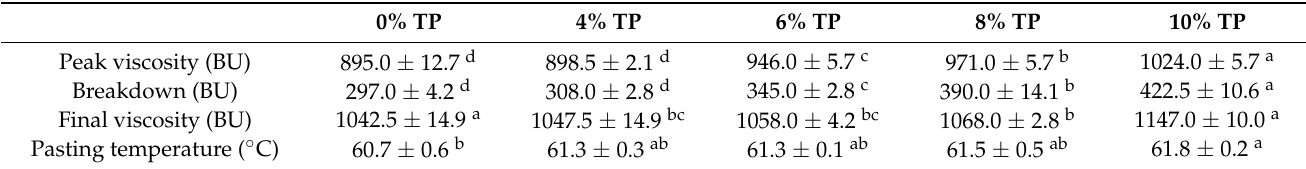
Table 1. Pasting properties (mean ± standard deviation) of the five blends used for the preparation of crackers with increasing quantities of tomato pomace